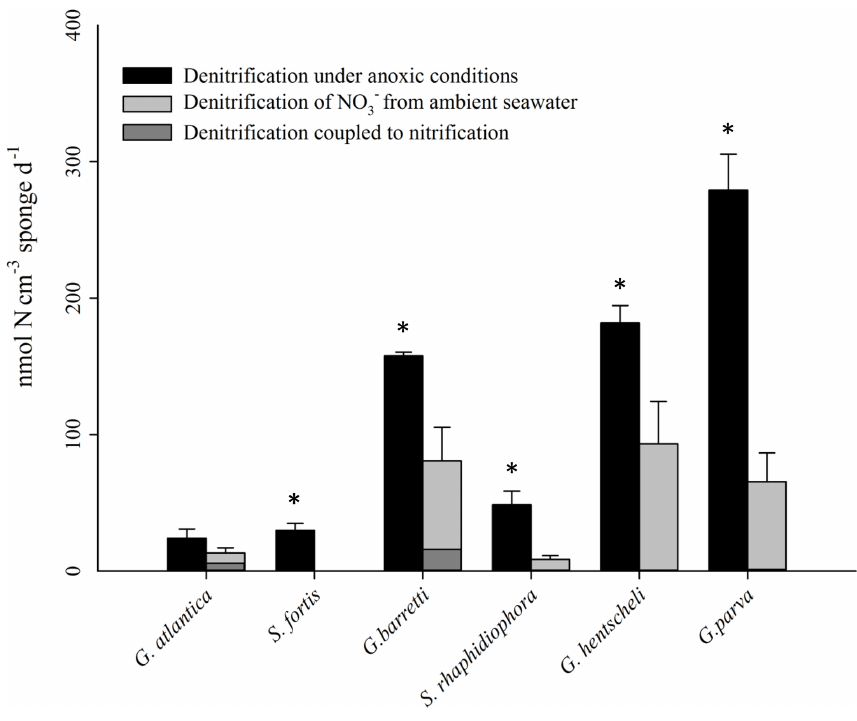
Figure 2. Sponge species-specific rates of denitrification in incubations with degassed site water (anoxic conditions, black bars) and air- saturated site water (oxic conditions, grey bars) for six key species from boreal and arctic sponge grounds. Statistically significant differences between denitrification rates in the presence and absence of dissolved oxygen are indicated by an asterisk for each species. Error bars indicate SE ( n = 3 individuals). Coupled nitrification–denitrification under oxic conditions is visualized with dark grey colour in the grey bars. Compare with Table